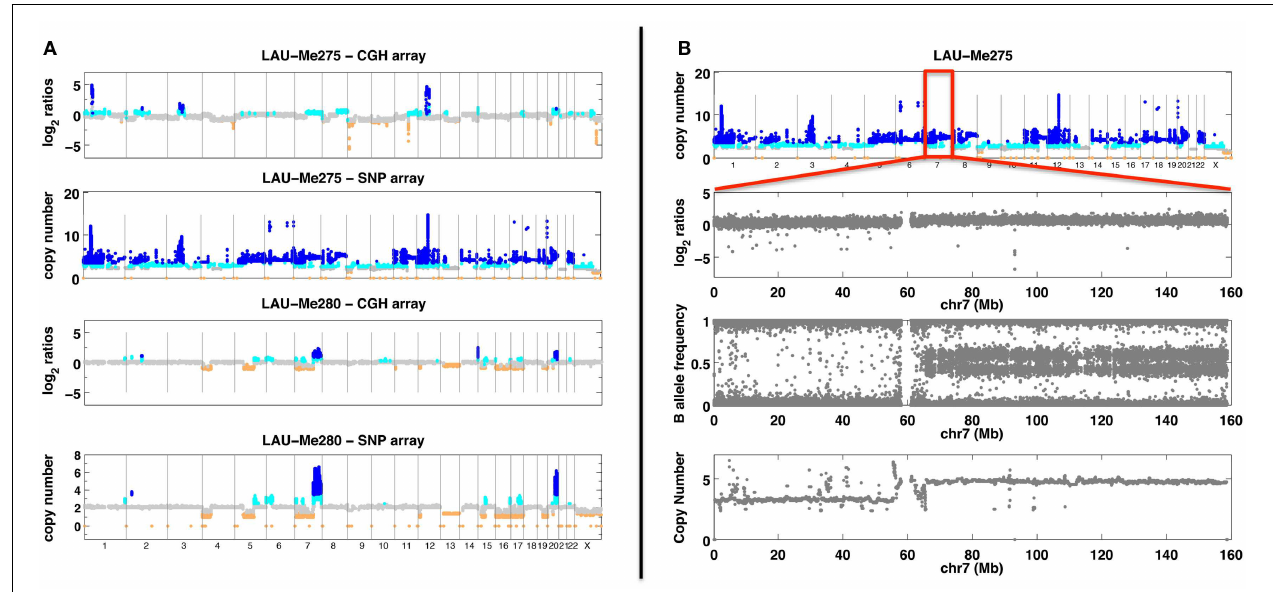
Colors indicate a copy number state (orange < 2 copies; gray = 2 copies; cyan = 3 copies; dark blue > 3 copies). (B) Analysis of the Me275 sample with SNP array.The top panel shows genome-wide copy number. Subsequent panels show chromosome 7 with, from top to bottom: hybridization log2 ratio, B allele frequency and copy number